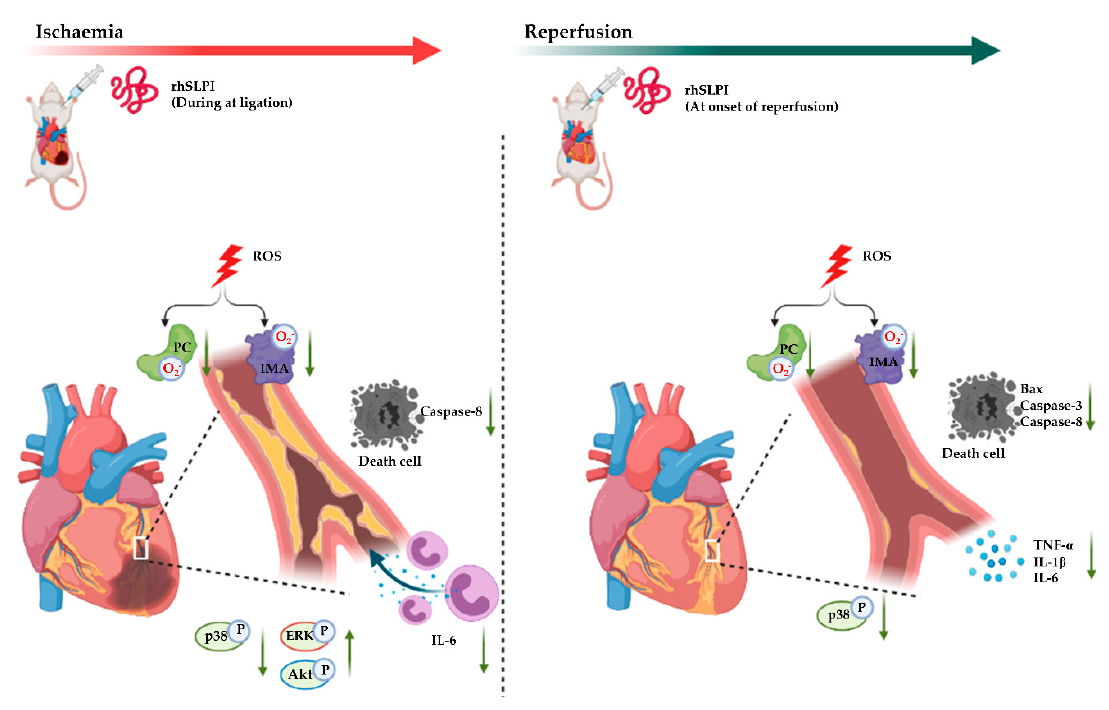
Figure 8. A schematic diagram of the major findings in this study. rhSLPI that was treated in the timing of the post-ischemia duration. rhSLPI could protect the heart from the ischemic condition. The mechanisms for this could be associated with the attenuation of intracellular ROS production, activation of Akt and p38 MAPK phosphorylation, reduction in inflammatory cytokines (TNF- α , IL-1 β and IL-6) and reduction in apoptosis regulatory proteins (Bax, caspase-3, caspase-8).